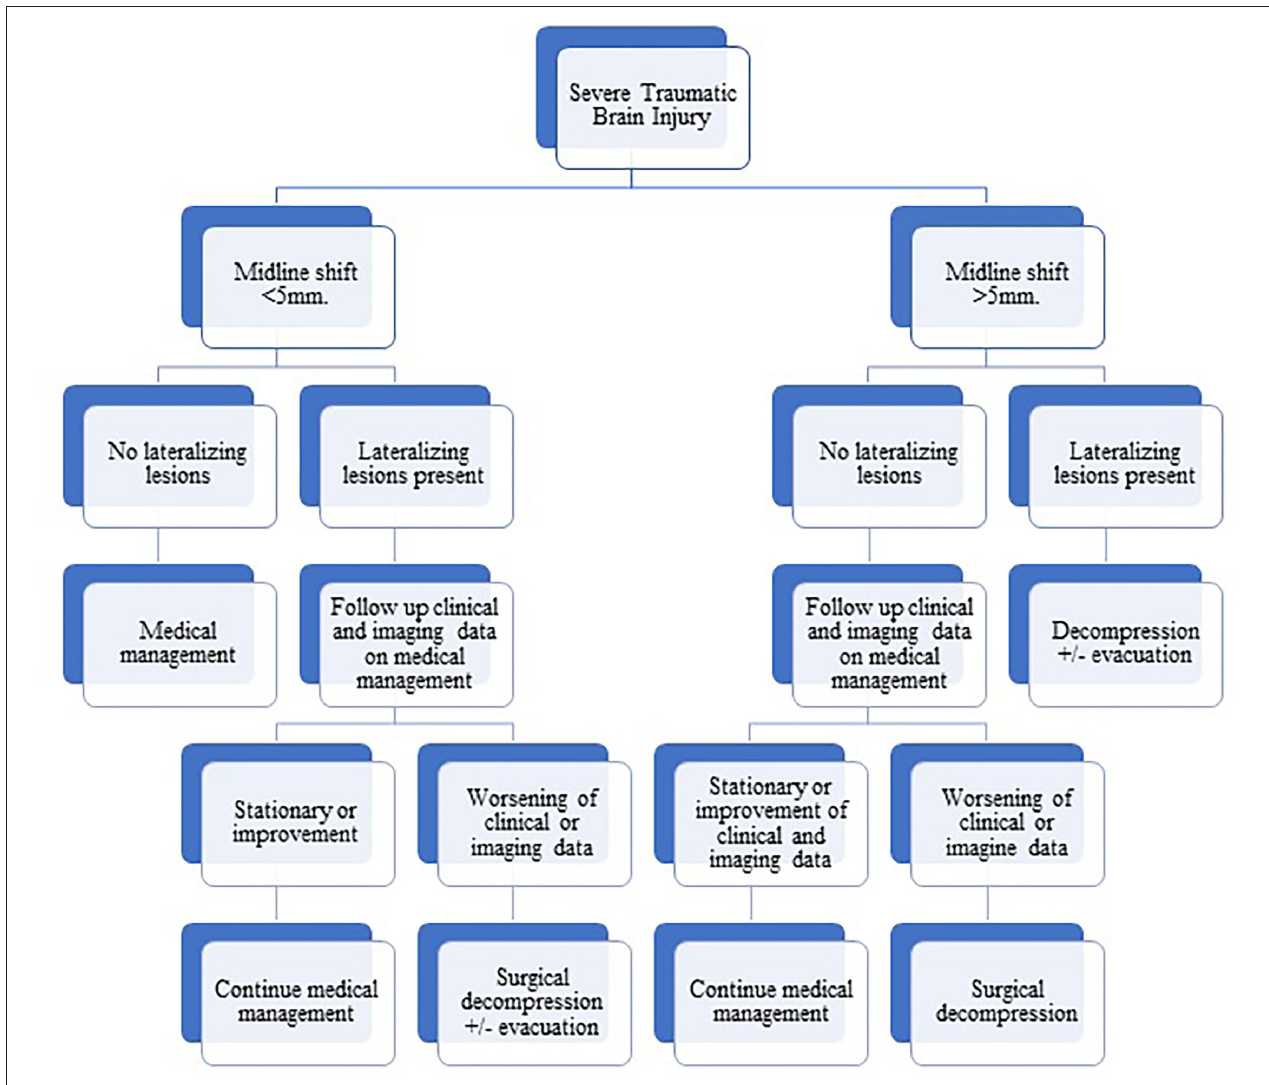
FIGURE 1 | Flowchart diagram showing our protocol of management of severe traumatic brain injury based on clinical and radiological